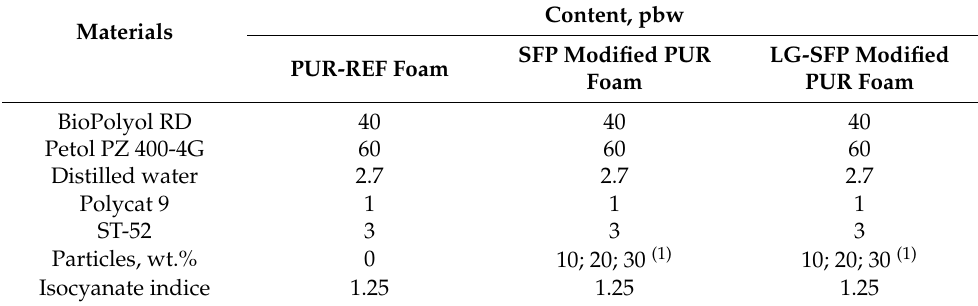
Table 1. Compositions of PUR-REF, SFP, and LG-SFP particles modified PUR foams. Content, pbw Materials PUR-REF